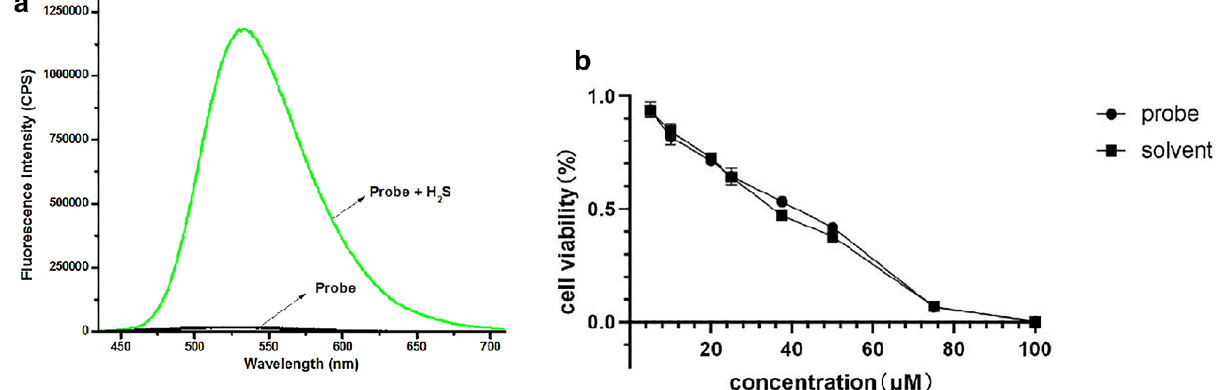
Figure 1. ( a ) The spectral changes of the probe before and after the reaction with H 2 S. ( b ) Toxicity